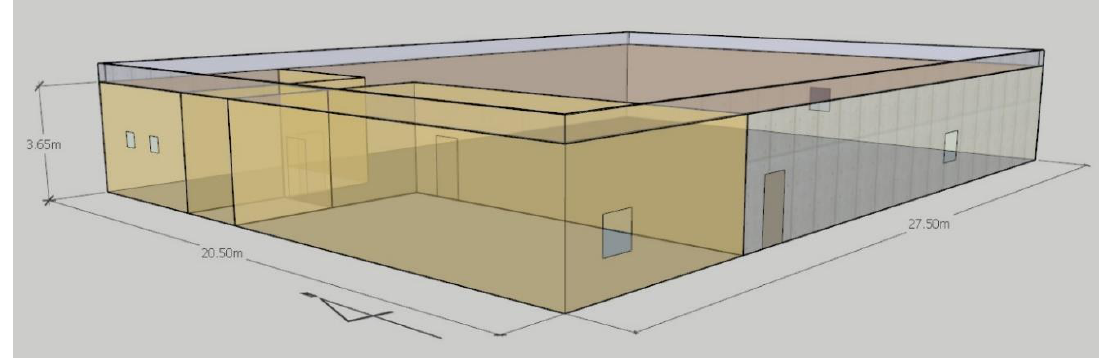
Figure 1. Schematic building model.